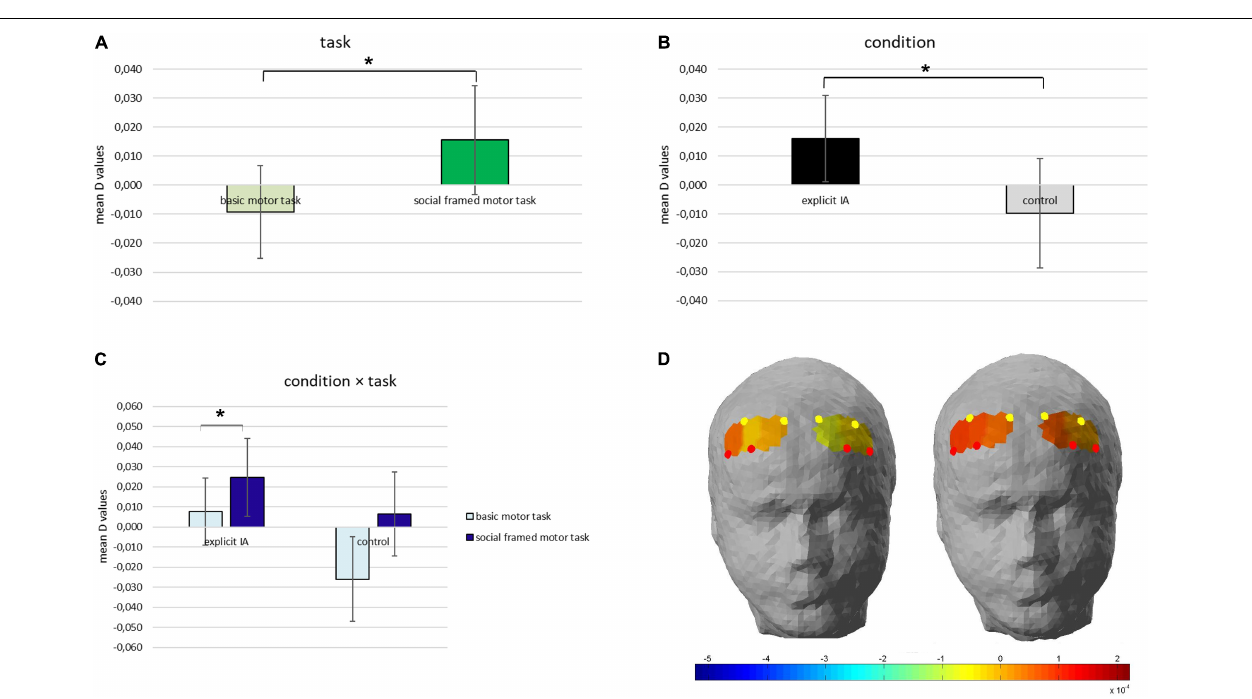
FIGURE 4 | (A–D) Oxygenated hemoglobin (O2Hb) evidence. (A) The graph displays O2Hb modulation [ (D) values] as a function of the Task, which is significantly increased for the social framed motor task compared to the basic motor task. (B) The bar chart shows significantly higher O2Hb values in the explicit IA